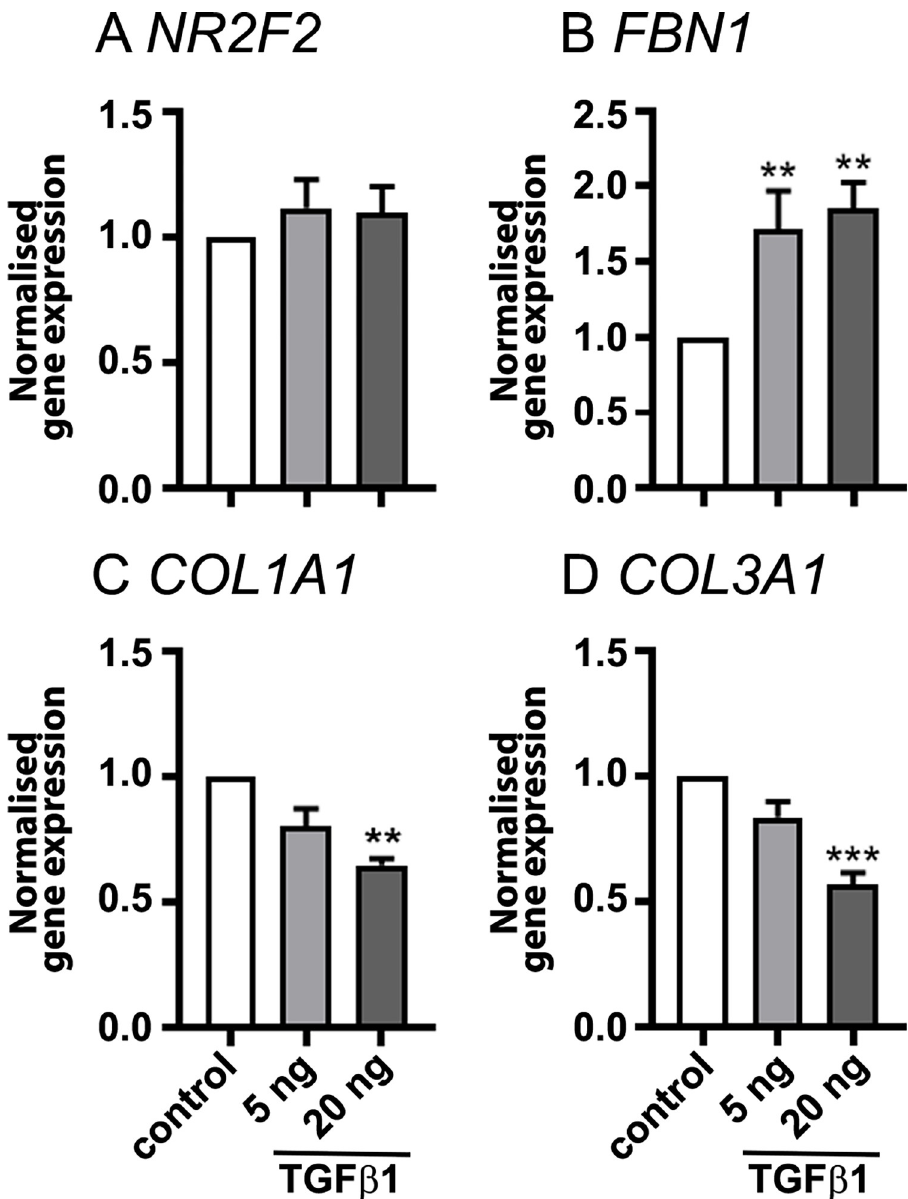
Fig 8. Normalised gene expression genes in fetal fibroblasts. Fibroblasts from bovine fetal ovaries (19–26 weeks, n = 6) were treated with 5 or 20 ng/ml TGF β 1 for 18 h. Fold changes of gene expression to the control groups are presented as mean ± SEM (normalised to PPIA and RPL32 ). Significant differences between groups were determined by one-way ANOVA with Tukey’s post-hoc test. �� P < 0.01, ��� P <